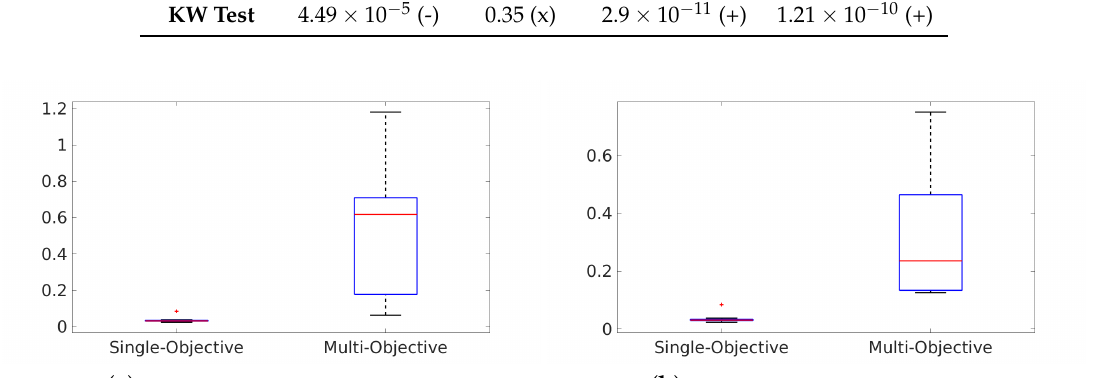
( a ) Box plot for cluster E ( b ) Box plot for cluster E 2 in test data 1 in test data Figure 8. Box plots of accuracy for both single- and multi-objective approach and cluster of